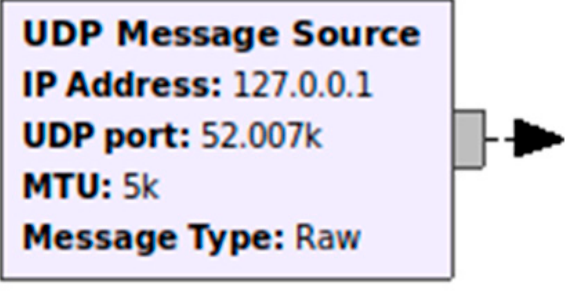
Figure 6. Data input block.